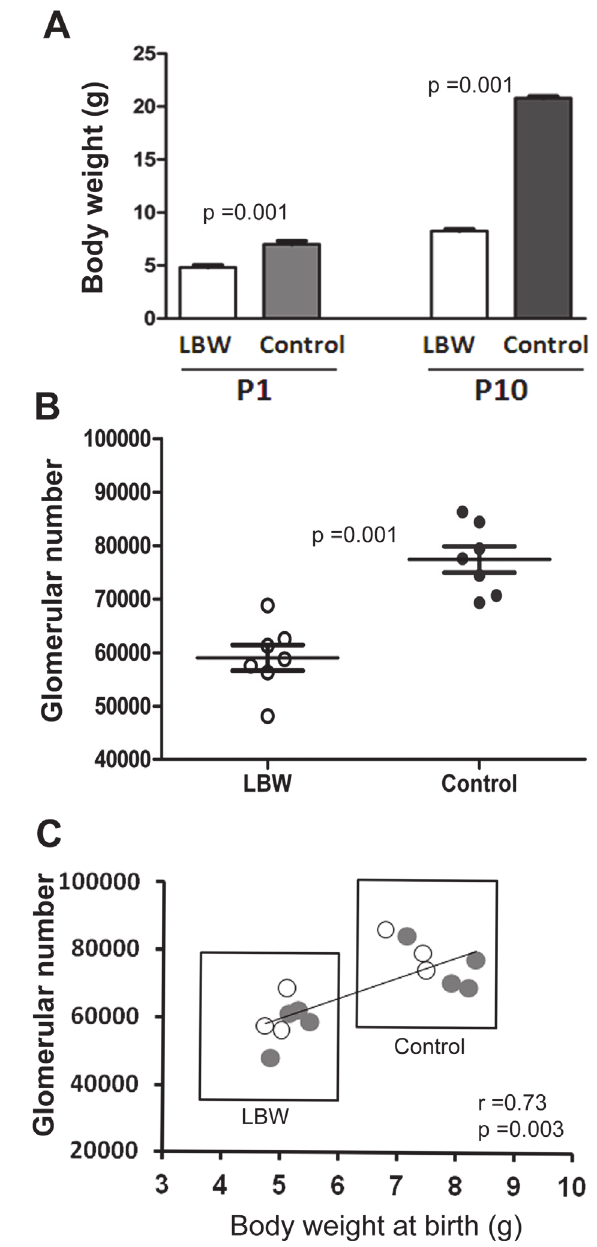
Fig 1. Body weight and glomerular number in low birth weight rats compared with controls. A: Body weight in low birth weight (LBW) rats compared with normal controls at postnatal day 1 (p1) and 10 (p10). Values are means with SD. B: Comparison of glomerular number between LBW and control rats at p10. Each circle represents an individual rat and the horizontal and vertical lines indicate the means and SD. p Value between LBW and control rats was calculated by the Mann-Whitney U-test, n = 7 for each group. C: Scatter plot showing the distribution of glomerular number based on birth weight. The number of glomeruli was positively correlated with body weight at birth. r = Spearman ’ s correlation coefficient. The open circles represent the three rats randomly selected for microarray analysis from each group.